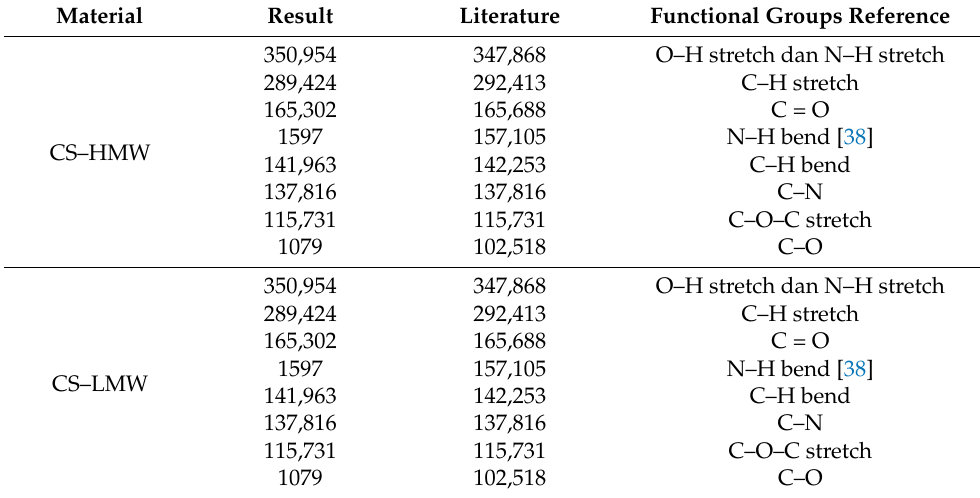
Table 3. FTIR wavenumber and corresponding functional